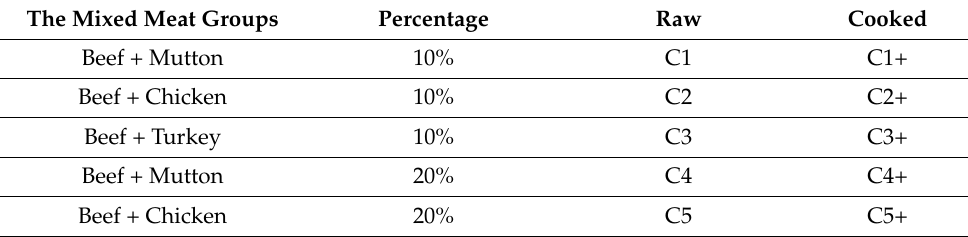
Table 2. Classification of mixed meat groups containing meats from two